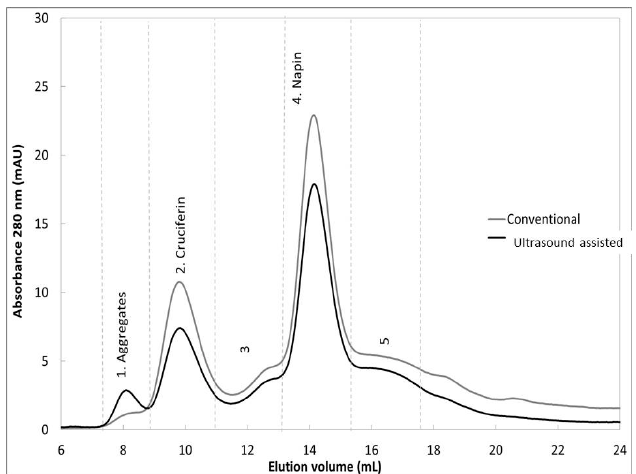
Figure 5. Seed storage protein content analysis by size exclusion chromatography (Superdex 75 column, Pharmacia, Broadway, CO, USA).